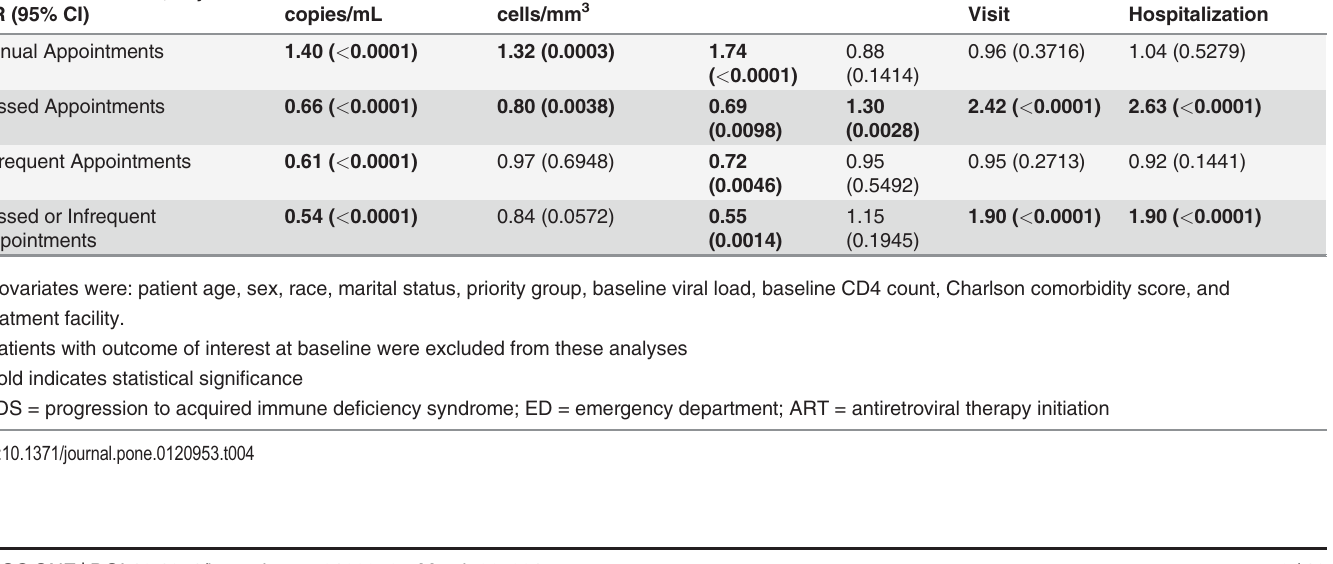
Table 4. Multivariable nominal logistic regression models for patient outcomes at 24 months: OR (p-value), n = 8,845 a,b,c, Retention Measures, adjusted OR (95%